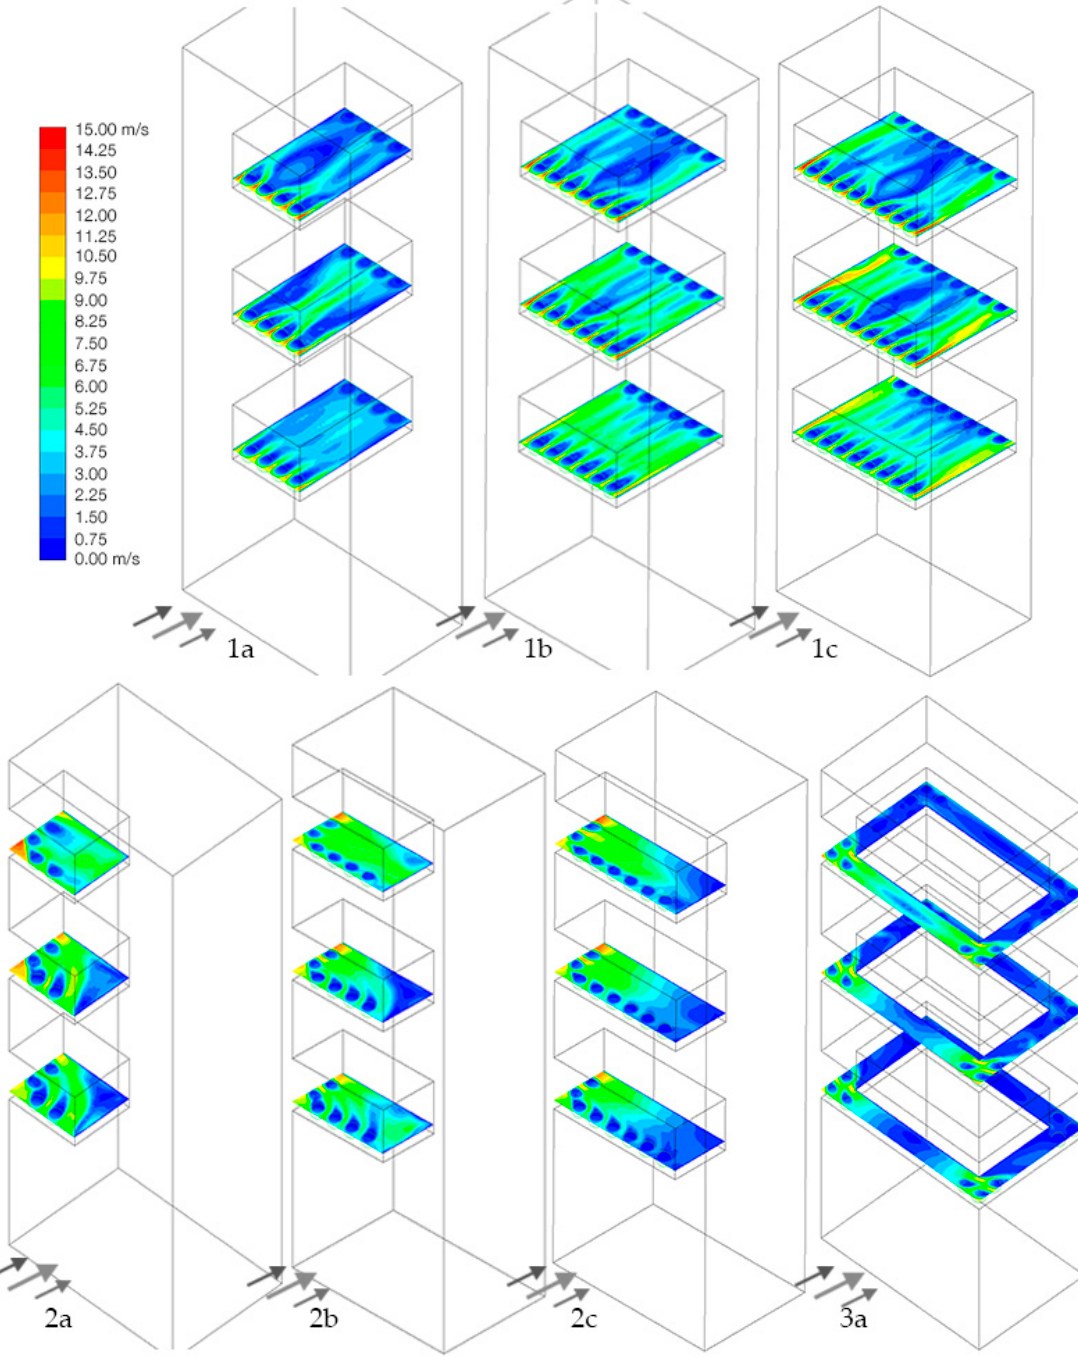
Figure 13. Velocity contour, at a height of 1.4 m, of the sky gardens with trees; (1a) Central sky garden b/B = 0.4, (1b) Central sky garden b/B = 0.6, (1c) Central sky garden b/B = 0.8, (2a) Corner sky garden b/B = 0.4, (2b) Corner sky garden b/B = 0.6, (2c) Corner sky garden b/B = 0.8, (3a) Periphery sky garden a/A = 0.5.